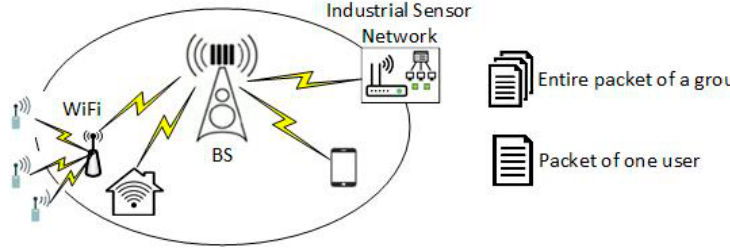
Figure 11. Illustration of a single user data packet and multiple user data packets relayed by a server/cluster head.